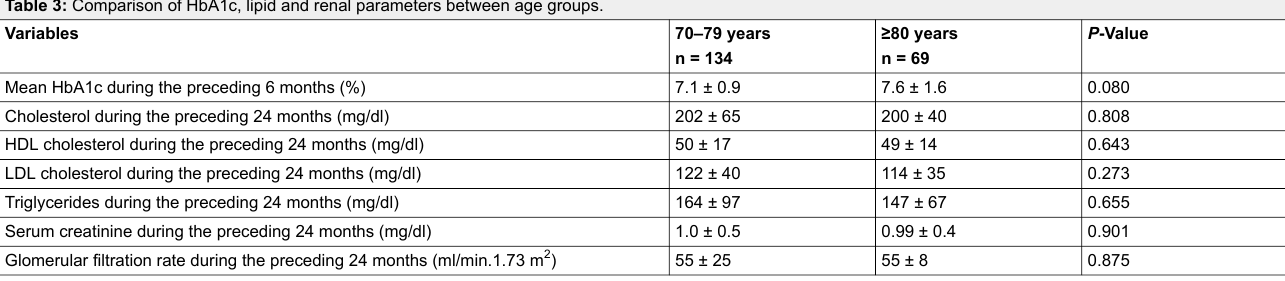
Table 4: Guideline